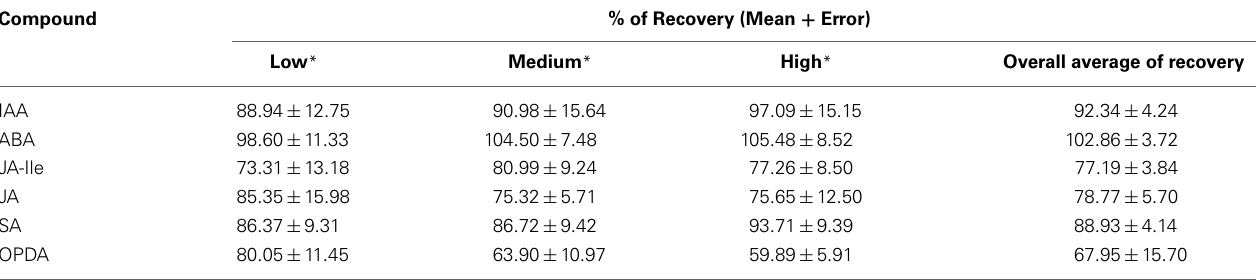
Table 4 | Percentage of recovery during the extraction of phytohormones in Arabidopsis thaliana . Compound